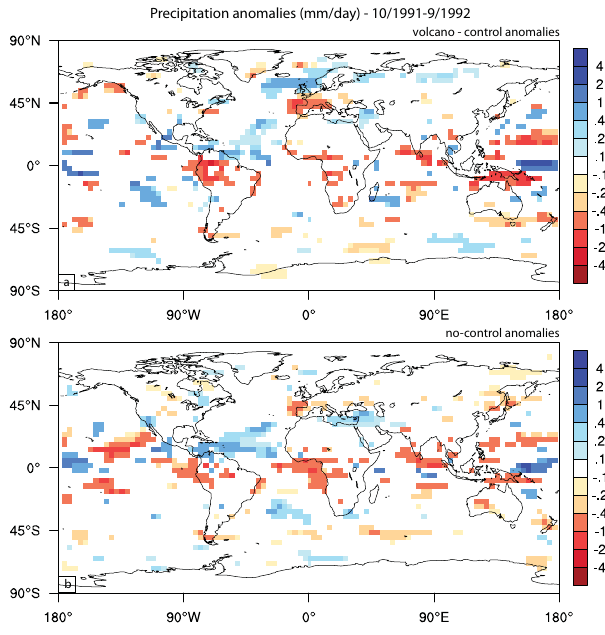
Fig. 3. Modeled surface temperature anomalies during the first Northern Hemisphere cold season following each eruption (October–March), averaged for all twelve eruptions in Table 1. Both anomalies using the volcano–control method (a) and the no-control method (b) are plotted here where significant at the 90% level.